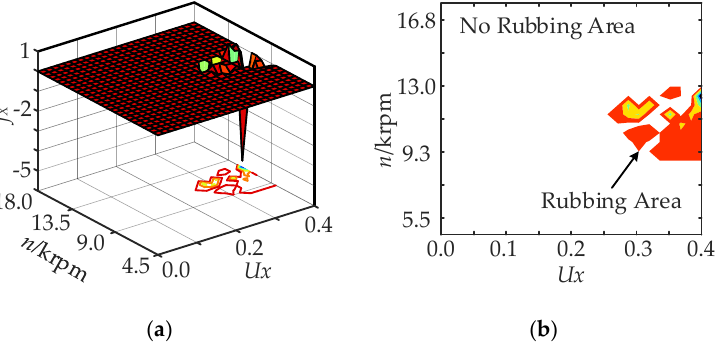
Figure 16. Rubbing force with different eccentricity ratio and rotation speed. ( a ) U x - n - f X diagram; ( b ) U x - n diagram.